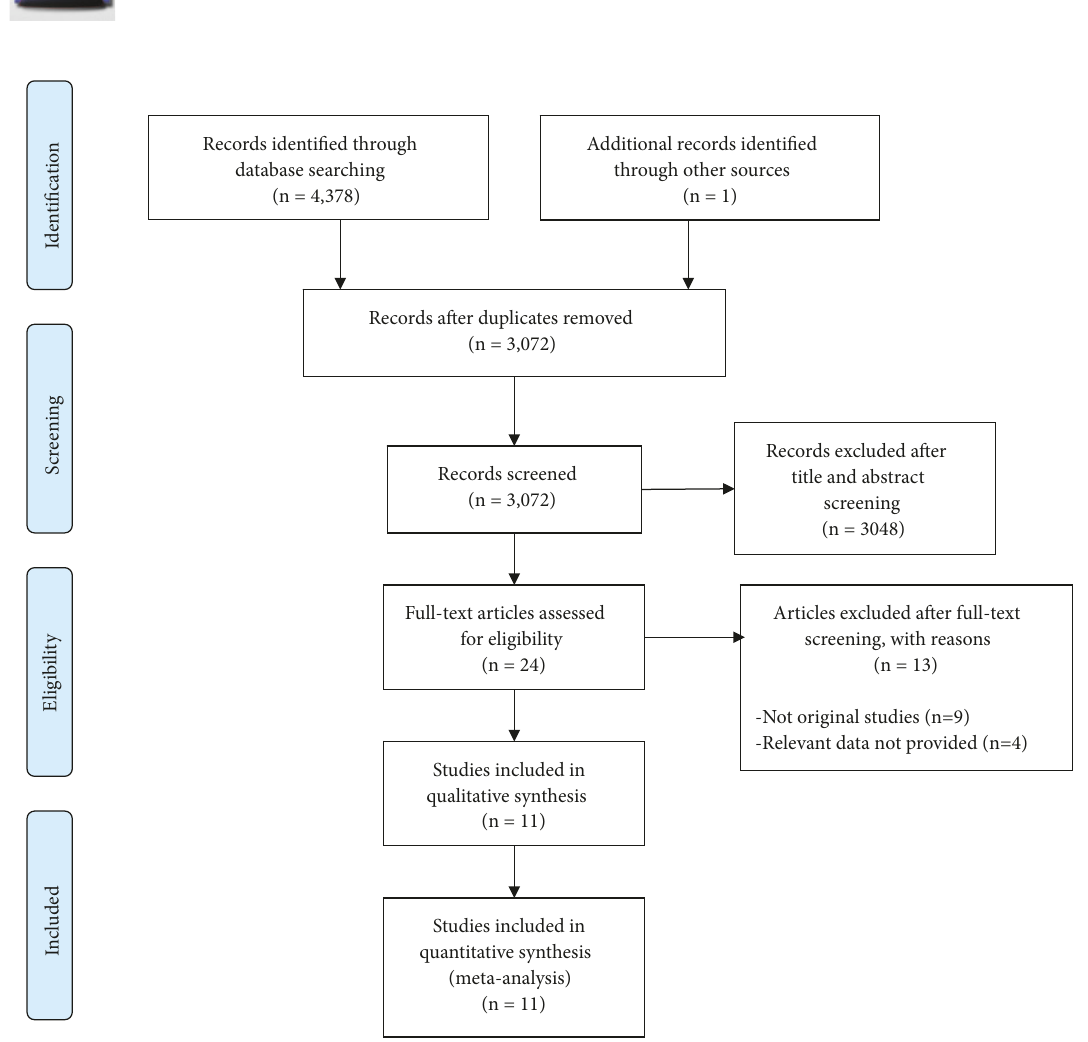
Figure 1: Study flow